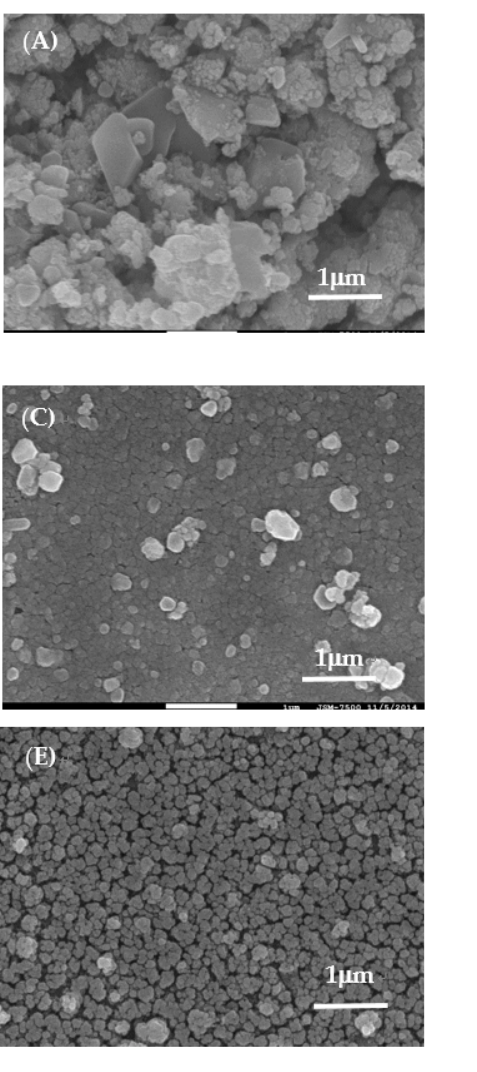
ductors [24]. By increasing the Zn content to 0.15 in the precursor solution (sample (B)), the surface microstructures changed to small plate-like microstructures with large amounts of small grain aggregates. Due to the increase in the intensity of the (1 1 2) crystal plane of Ag 2 ZnSnS 4 , the microstructures of the sample changed from plate-like microstructures to small spherical aggregates.